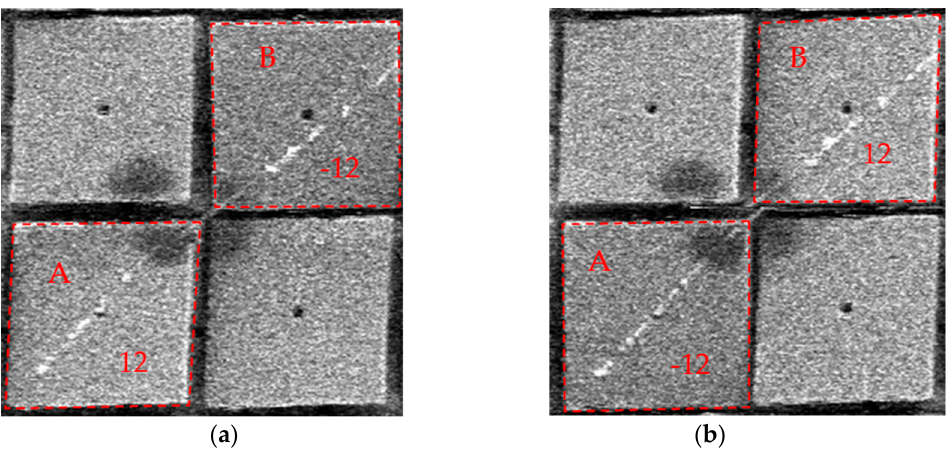
Figure 7. In situ SEM torsional fatigue testing of a 100 nm Ag nanowire: the two mirrors always tilted towards the opposite directions in each cycle. In ( a ) mirror A flipped to 12° and mirror B flipped to − 12°. After almost four hours of cyclic loading, the nanowire fractured like ( b ).